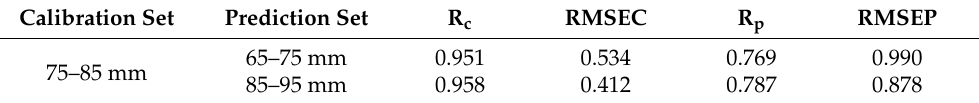
Table 4. The fruit size group alone predicted the SSC results of other fruit size